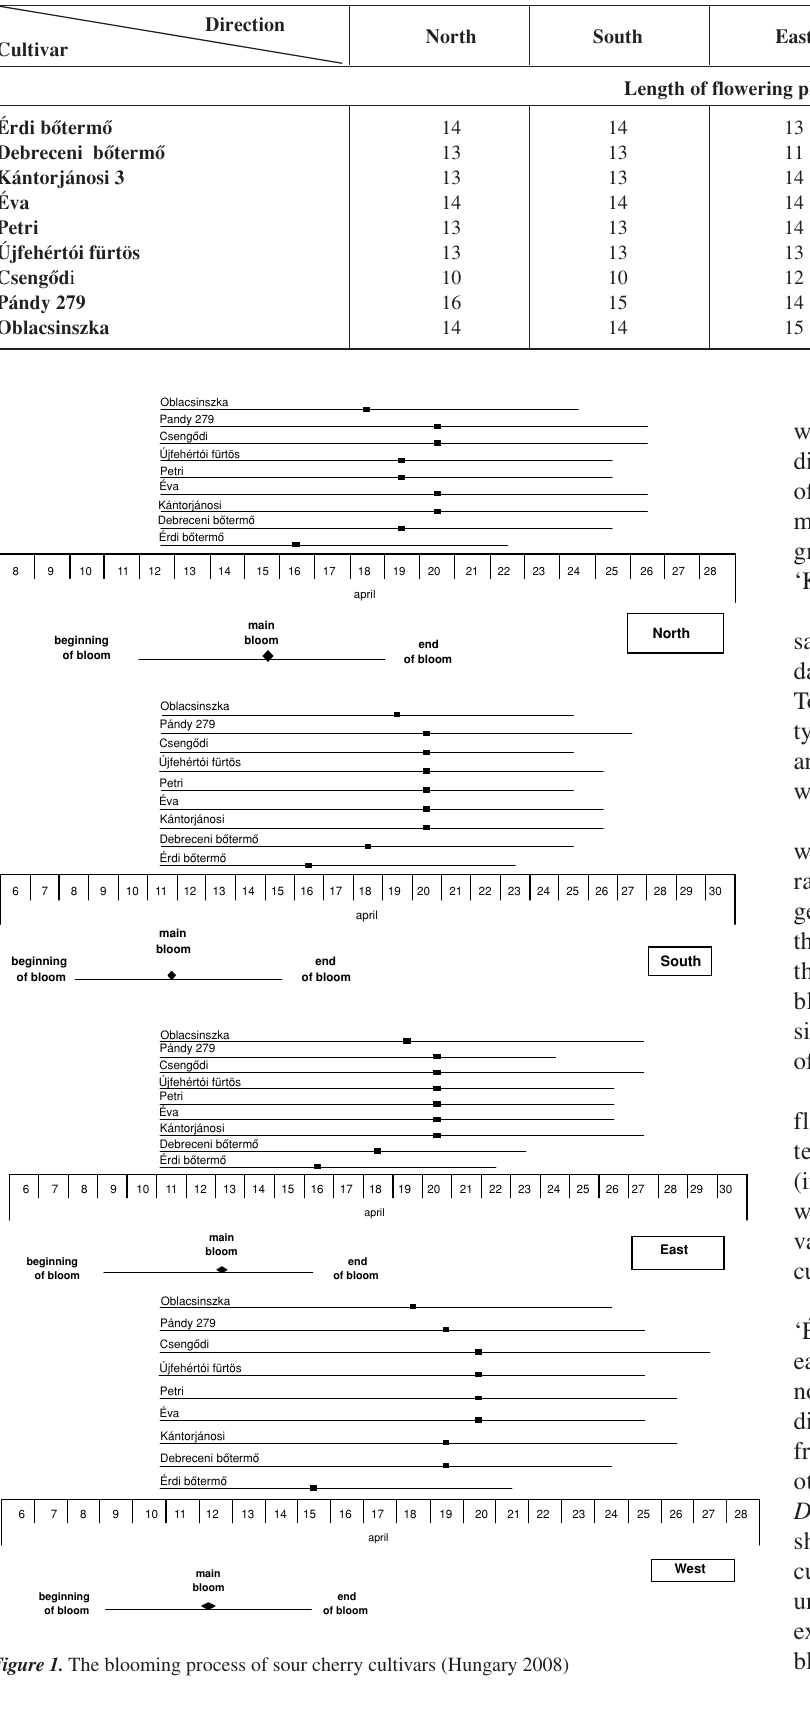
Table 1. Length of flowering phenophases of sour cherry cultivars